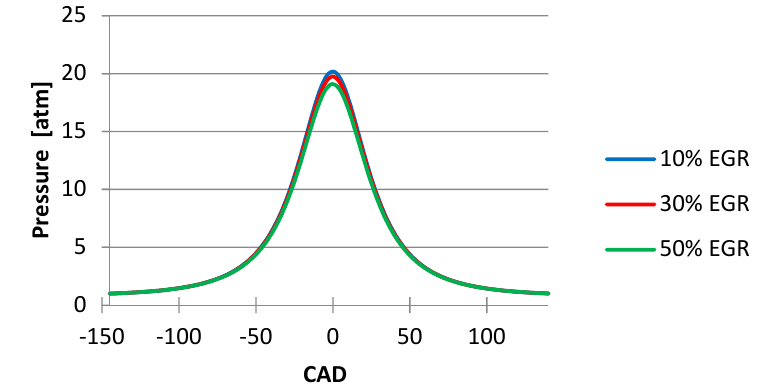
Figure 4. EGR ratio influence on temperature inside the cylinder.